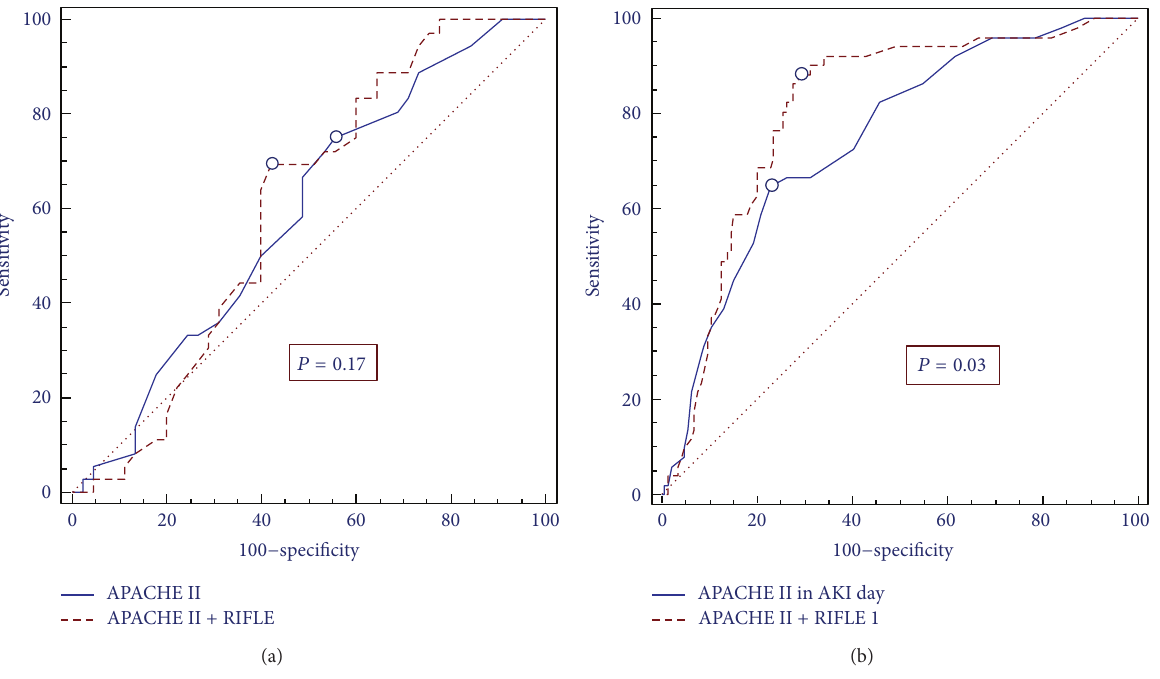
Figure 2: Comparative analysis between the ROC curves and the APACHE II score and calculated after incorporating the RIFLE